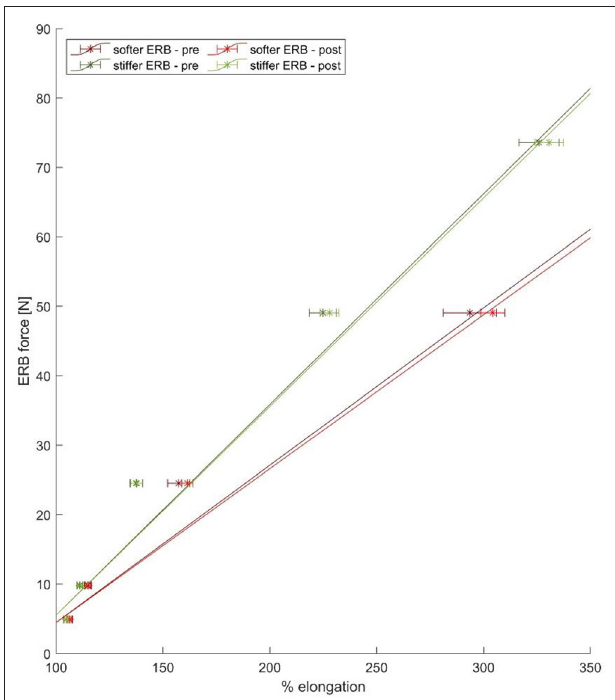
FIGURE 2 | The mean force–elongation curve of the stiffer (green line) and softer (red line) ERBs obtained from the experimental data points (six points for the stiffer and five points for the softer ERB) based on the pre- (blue lines) and post (red lines)-data collection validation experiments.